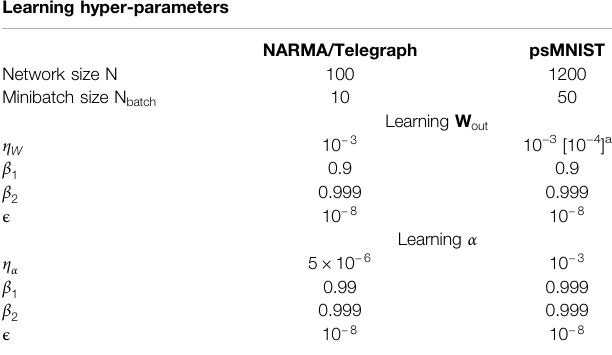
TABLE 1 | Table of the hyper-parameters adopted in the online learning process. η is the learning rate in each case, while β Adam optimiser (further details are given in the Supplementary Material ).